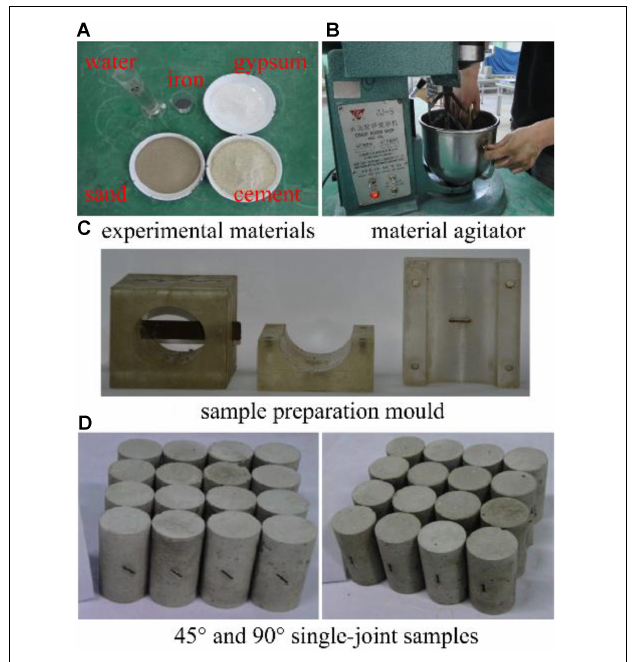
FIGURE 1 | Single-joint sample preparation.